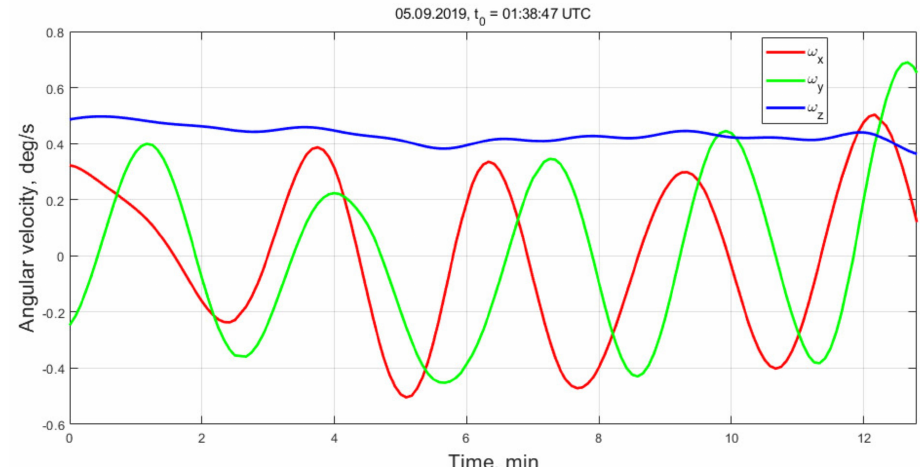
Figure 17. Angular velocity in the body reference frame.